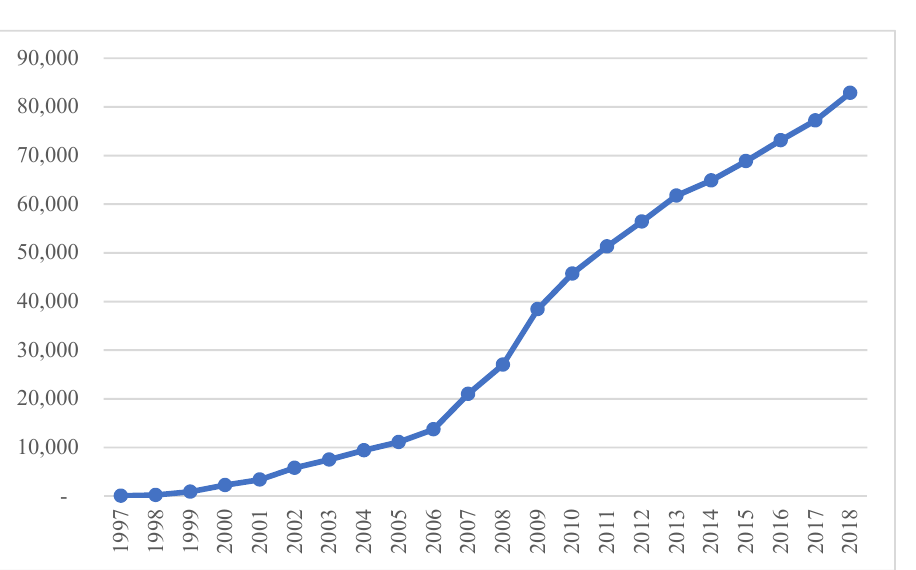
Figure 1. Number of internet users (in 10 thousand) in China from 1997 to 2018. The horizontal axis represents the year from 1997 to 2018. The vertical axis shows the number of internet users (in 10 thousand) in China.